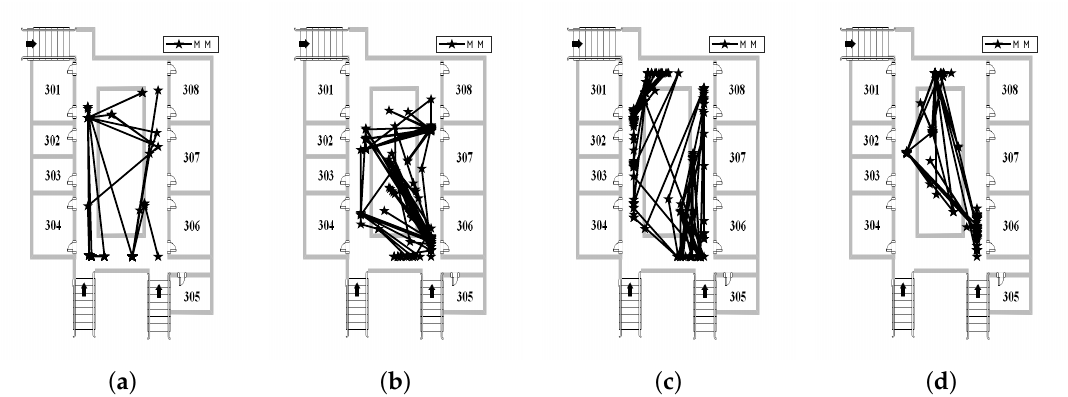
Figure 5. Positioning results for MM in teaching building: ( a ) calling; ( b ) dangling; ( c ) handheld; and ( d ) pocket.